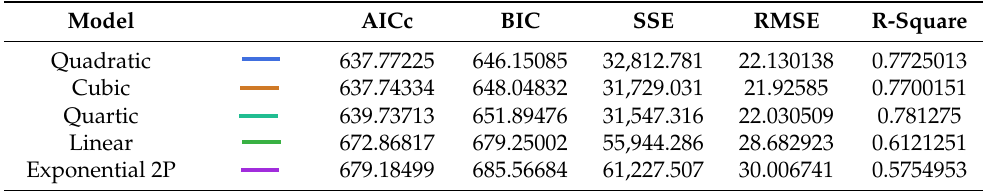
Table 8. Comparison table of the model for analyzing the number of holes drilled up to the moment of tool damage and feed rate.